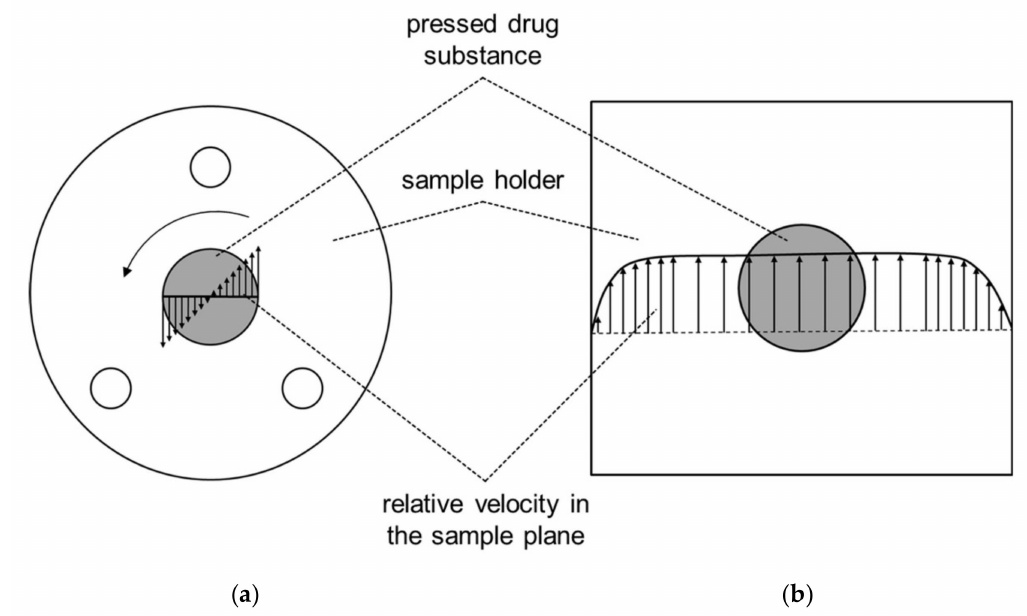
Figure 1. Relative velocity vectors for intrinsic dissolution (PhEur 9.0 chapter 2.9.29) ( a ) and the novel flow channel ( b